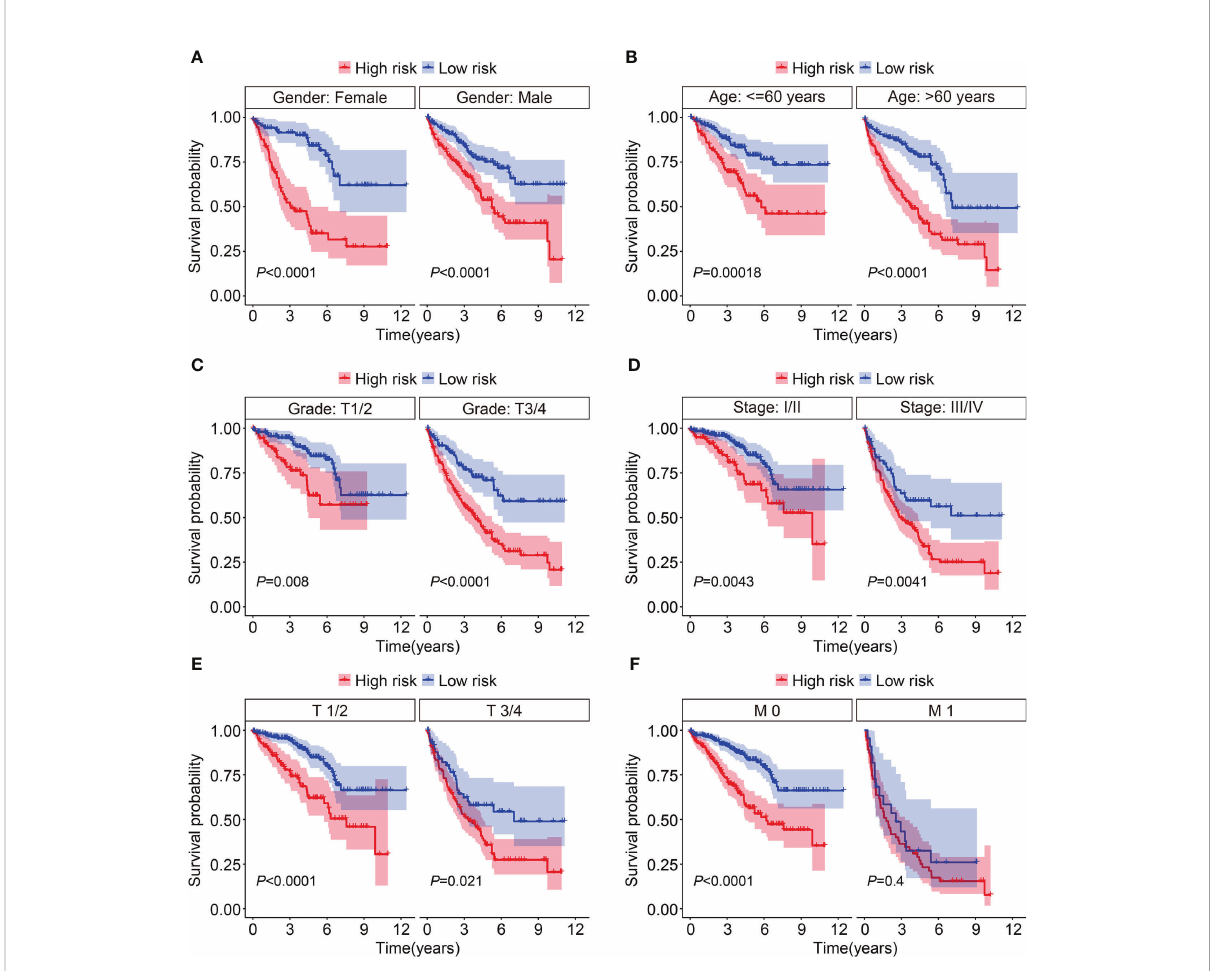
FIGURE 4 Kaplan-Meier survival curves to compare overall survival of high- and low-risk groups in subgroups strati fi ed by gender (A) , age (B) , grade (C) , stage (D) , T and M status (E, F)